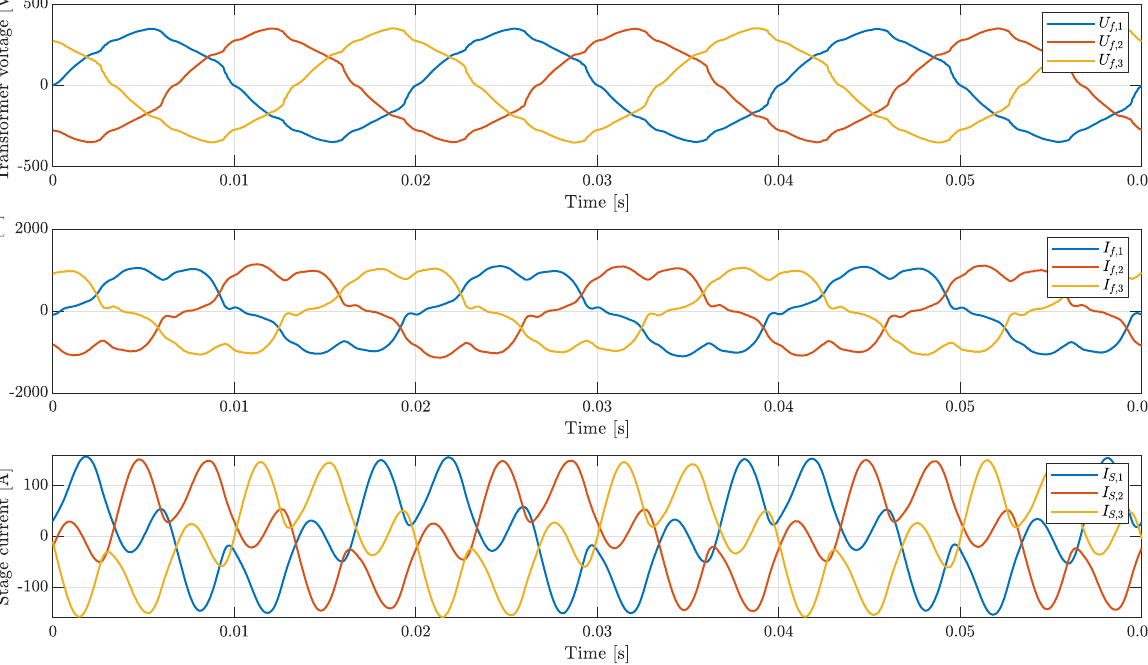
Figure 22. C2—Secondary voltage and current of transformer T1 and stage current without